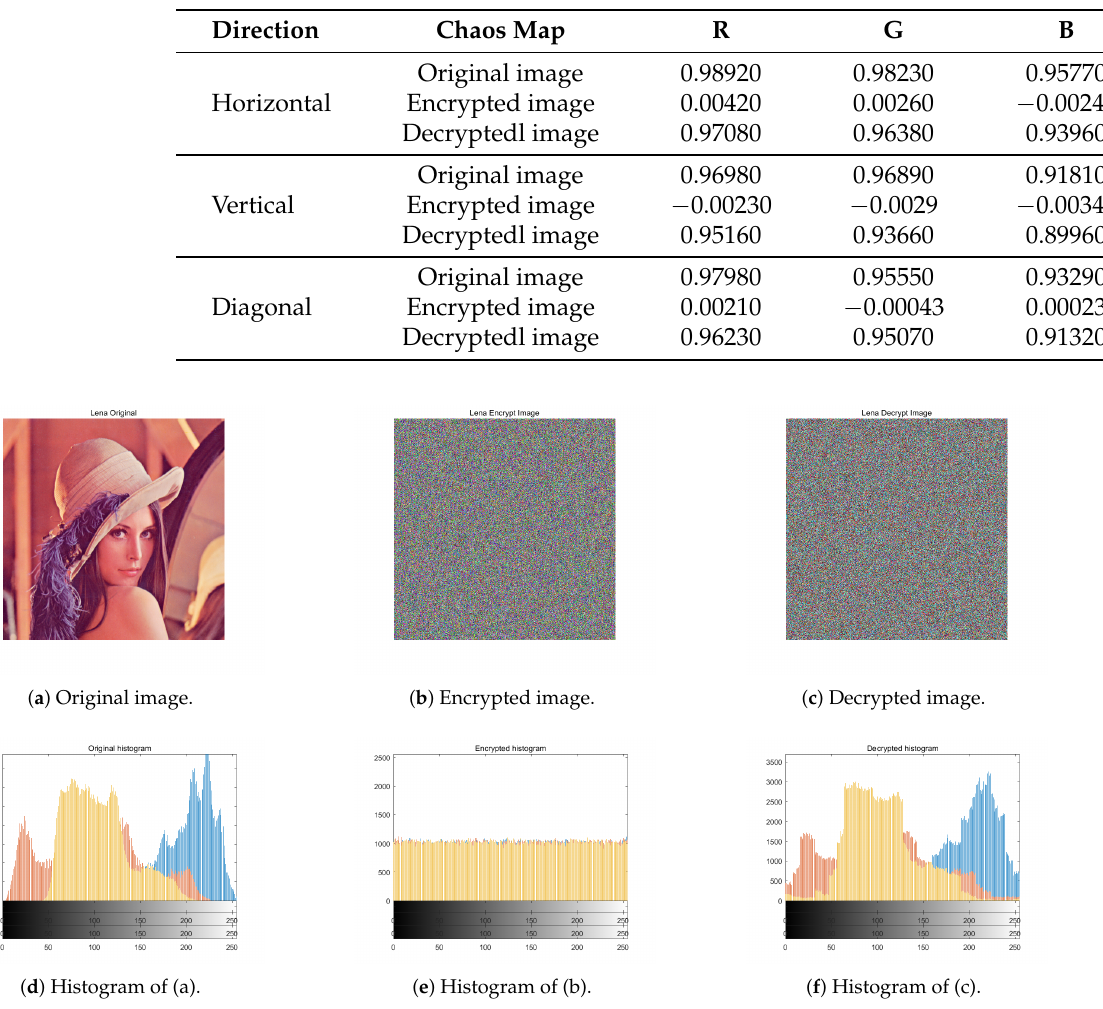
Table 1. Correlation coefficients for encrypted and decrypted color images of “Lena.tiff”.